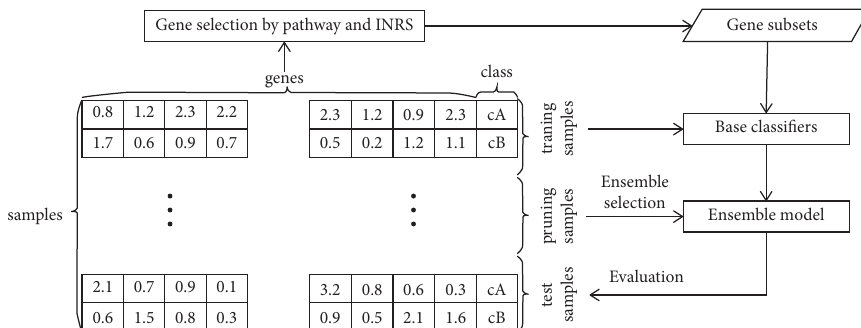
Figure 2: An overview of classifying microarray